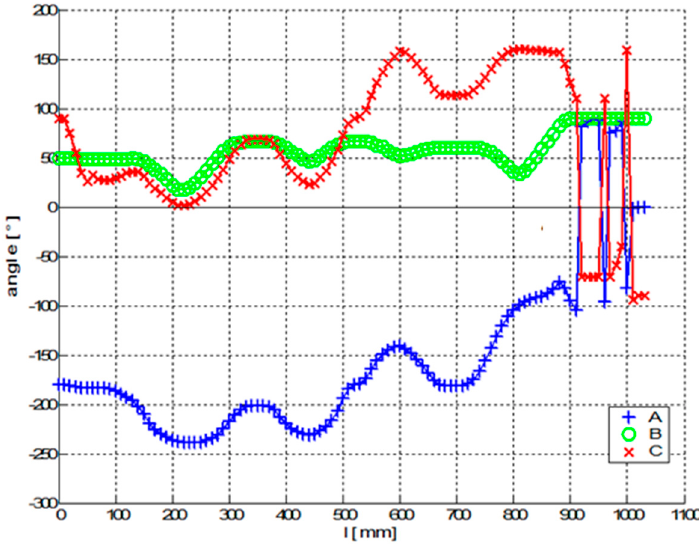
in relation (10). The determination TCP during the passage of the frame OPT TCP . OPT